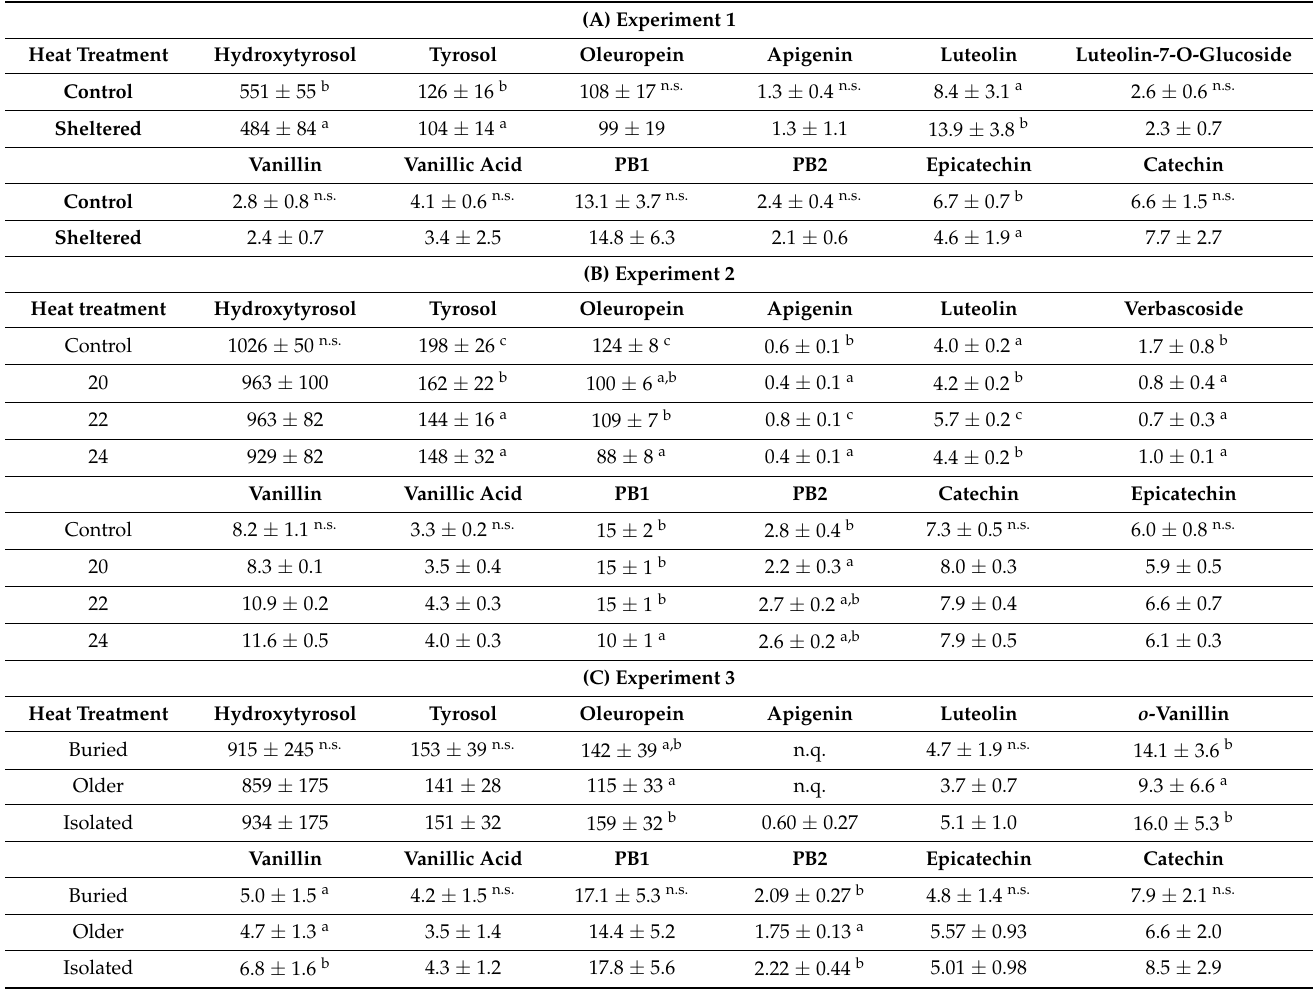
Table 2. Phenolic concentration of table olives (mg/kg) at the end of the fermentation process. Results are expressed as mean ± SD of the three sample replicates. Different superscript letters within the same columns indicate statistically significant differences (Duncan ´ s Test, p < 0.05) between thermal treatments. PB1 and PB2: procyanidin B1 and